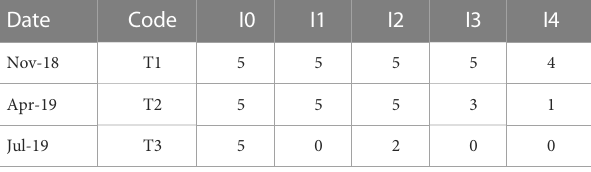
TABLE 2 Cerastoderma edule samples collected in Lombos do Ulla used for the transcriptomics approach classi fi ed by infection